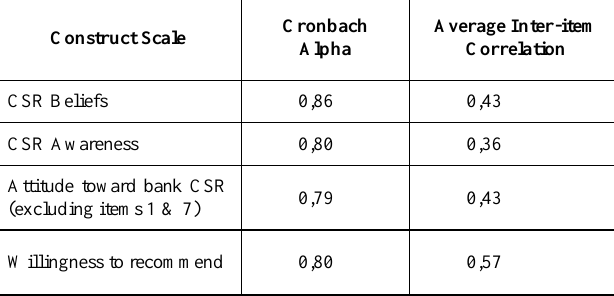
Table 3: Summary of construct item-reliability analyses